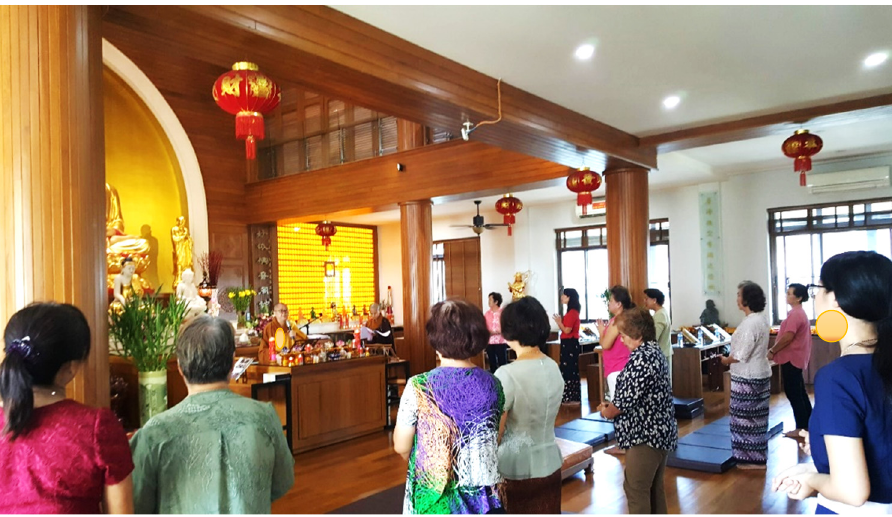
Figure 10. Sino-Burmese laity listening to Ven. Hongxing giving a lecture at Luohan Si (Source: